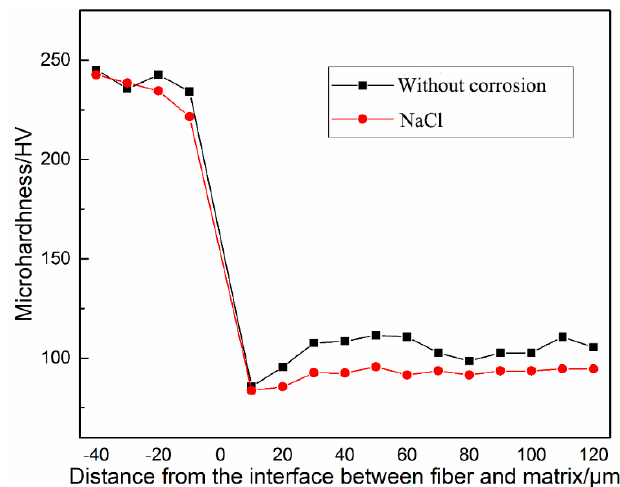
Figure 5. Micro-hardness of interface layer between zinc phosphate modified fiber and concrete matrix.